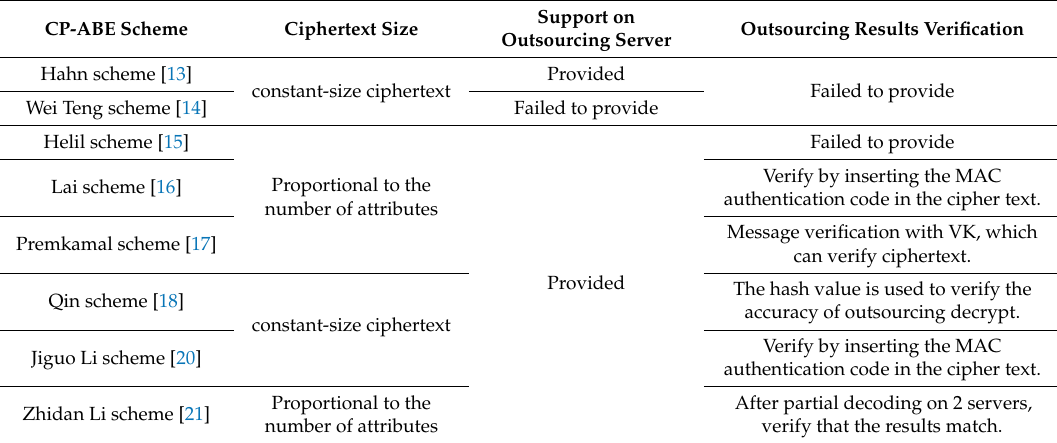
Table 2. Comparison of CP-ABE schemes with outsourced